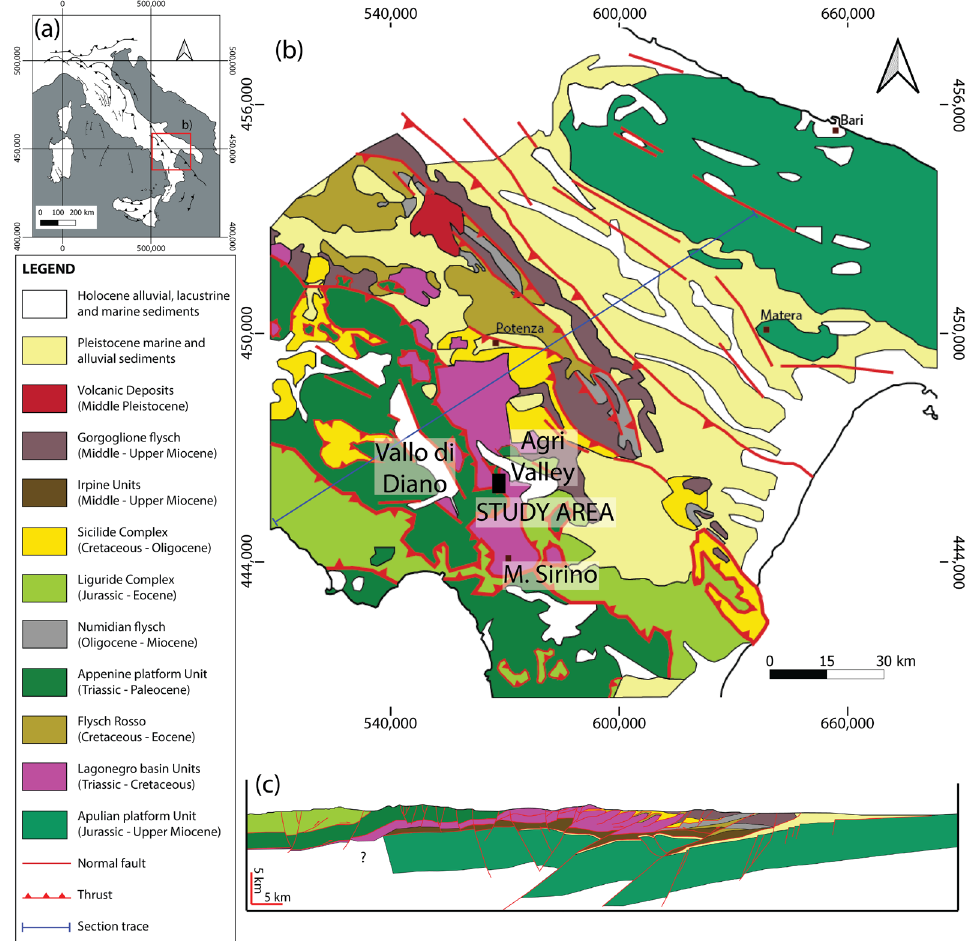
Figure 1. ( a ) Structural map of Italy and legend of the geological map and cross section; ( b ) Geological–structural map of the Southern Apennines. ( c ) Regional geological cross-section across the Southern Apennines from the SW to the NE, redrawn and modified based on Piedilato and Prosser [62].